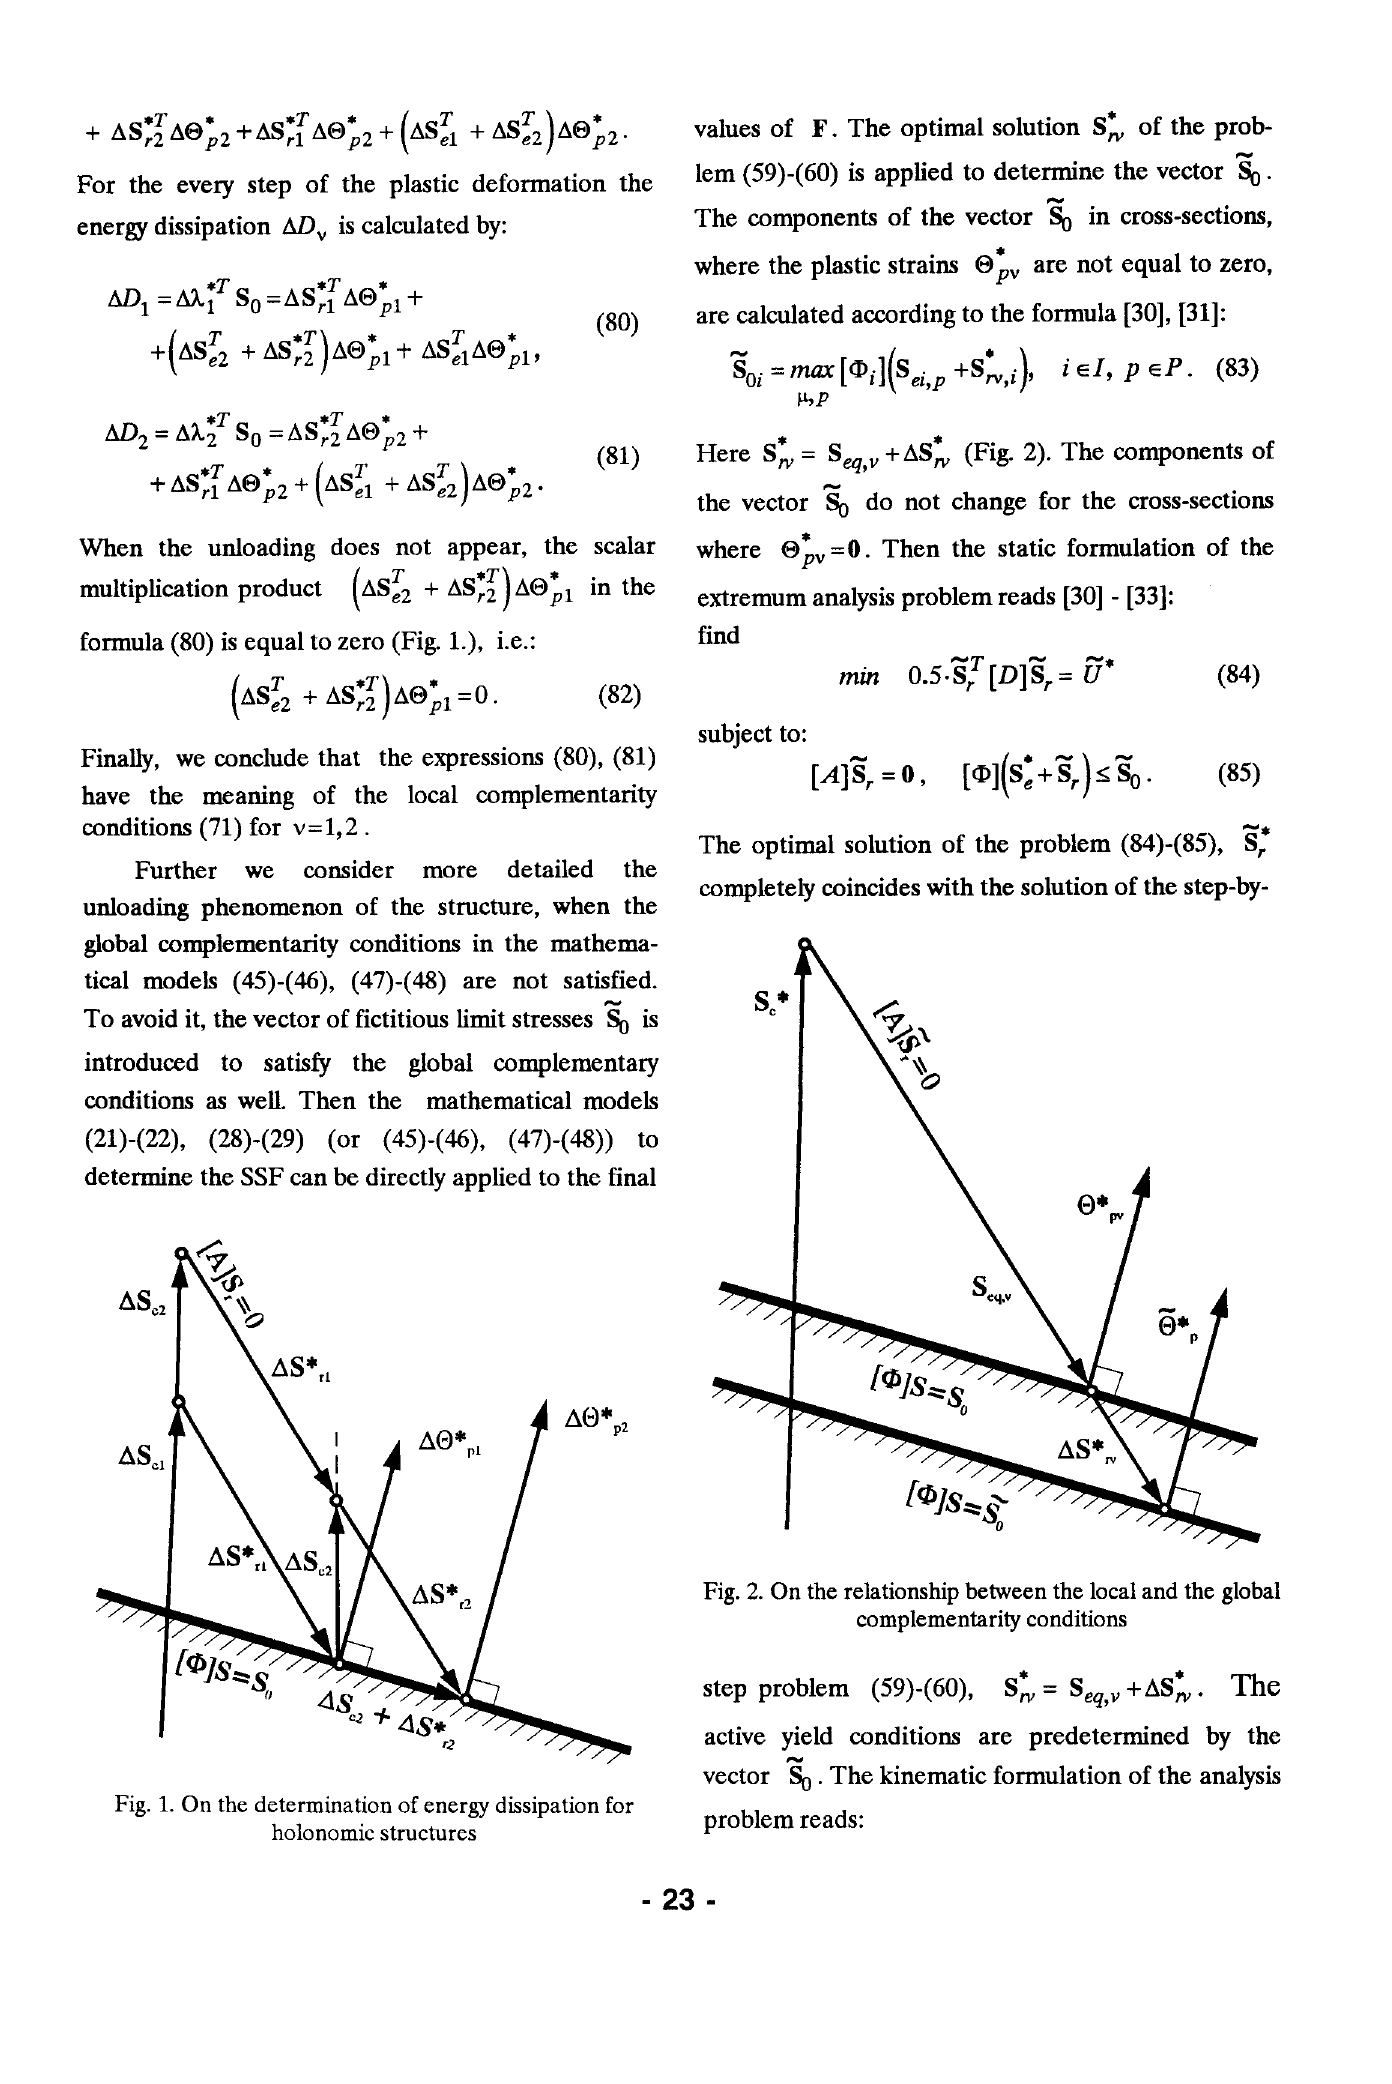
Fig. 1. On the determination of energy dissipation for holonomic structures